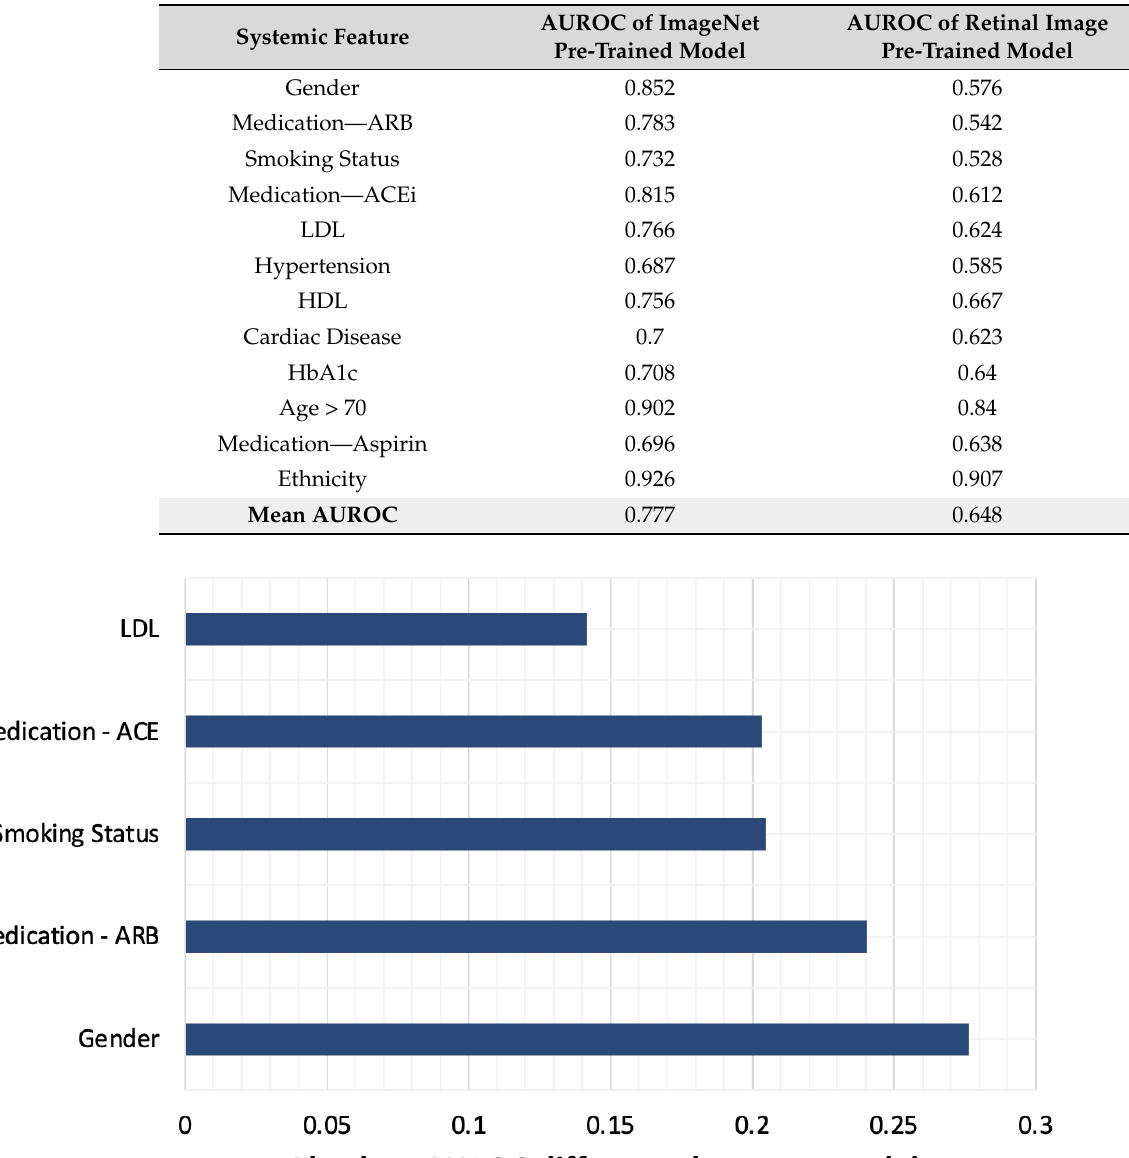
Table 3. Comparing ImageNet pretrained and retinal image pretrained model performances. The achieved area under the receiver operating characteristic curve (AUROC) for each of the 12 systemic features are listed. The mean AUROC achieved across all features was found to be statistically significant between the two models ( p < 0.001).